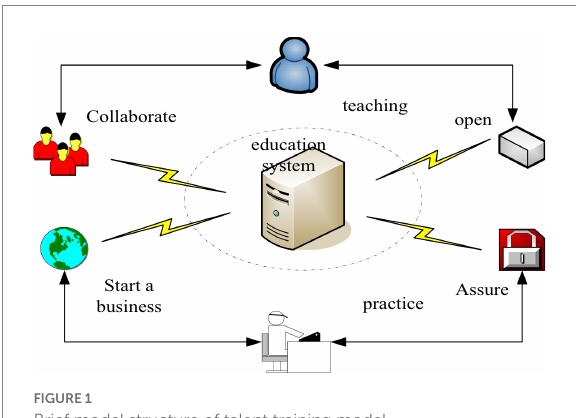
FIGURE 1 Brief model structure of talent training